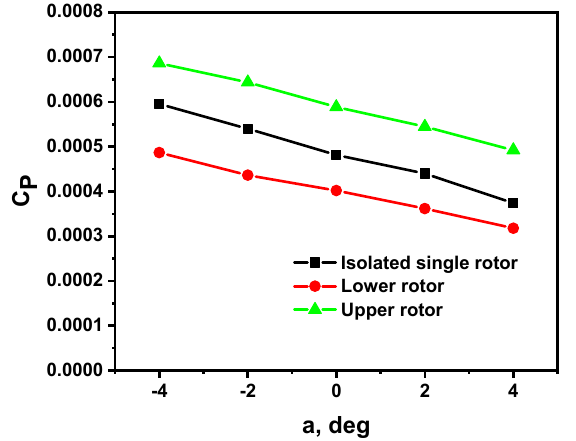
Figure 21. Variations of thrust coefficients (C T ) with rotor shaft tilt angles (a) for coaxial and isolated single rotors.